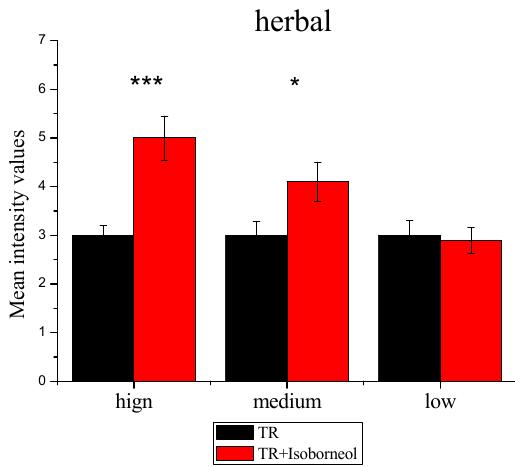
Figure 5. Aroma effect of three levels of isoborneol with terpenes recombination. *, p < 0.05; **, p < 0.01; ***, p < 0.001. TR, terpenes recombination. Error bars represent standard error deviation.